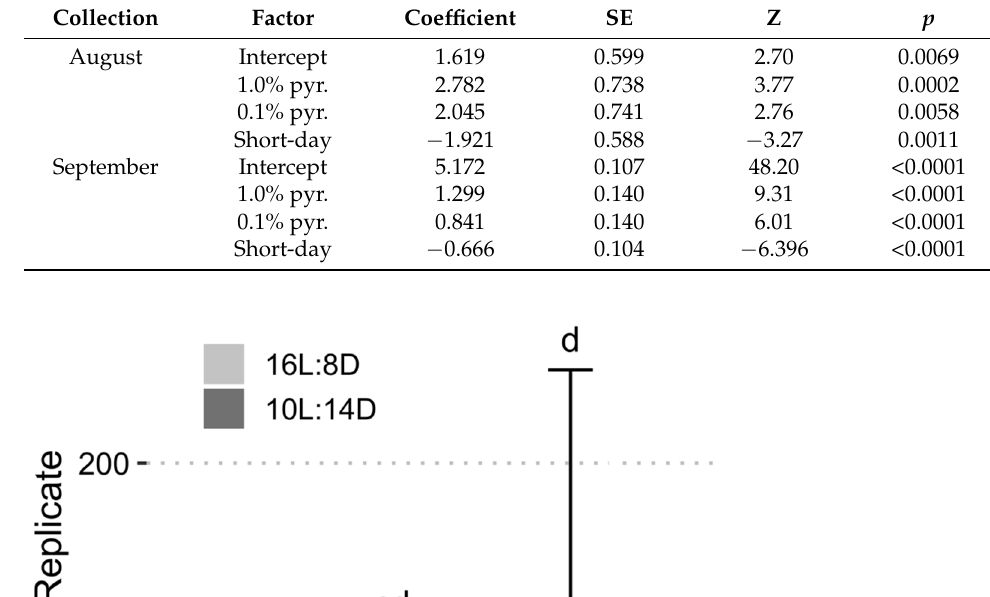
Table 2. Regression coefficients representing the influence of pyriproxyfen (pyr.) and photoperiod treatments on egg production. Egg production by Megacopta cribraria was significantly greater due to 1.0% pyriproxyfen and long-day treatment compared with the 0.1% and short-day treatment in the August experiment and was increased by all treatments in the September experiment. The model intercept represents the long-day + acetone treatment, which serves as the referent group. Coefficients and errors present on the log scale.